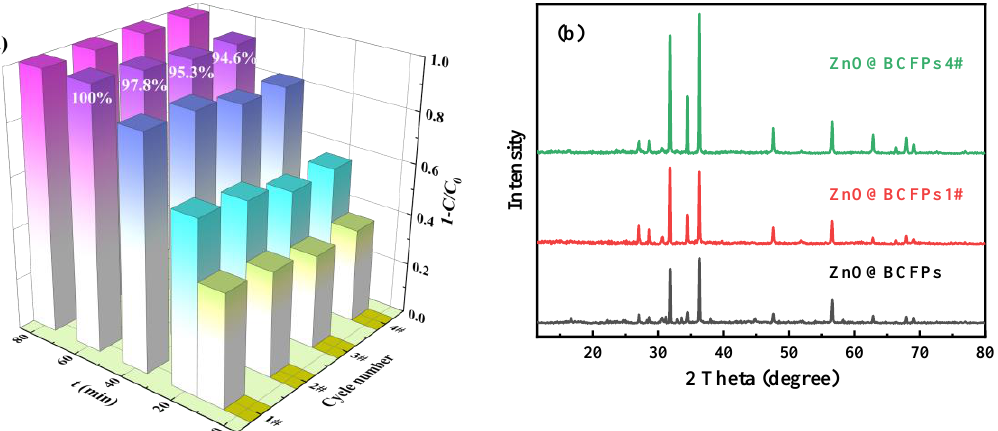
Figure 12. Reusability test of particle electrodes ( a ) and XRD of particle electrode before and after metronidazole degradation ( b ) ([metronidazole] 0 = 15 mg L −1 , [Na 2 SO 4 ] 0 = 0.05 mol L −1 , current density = 8.00 mA cm −2 , dosage = 10.00 g L −1 , pH = 7, O 3 aeration rate = 0.4 L min −1 ).